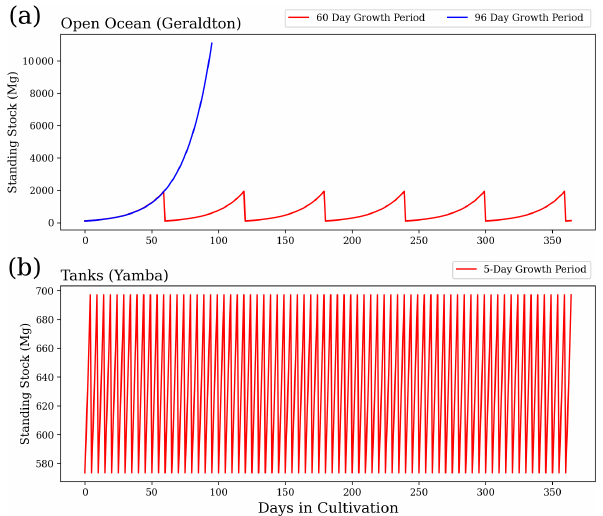
Figure 2. Standing stock biomass of Asparagopsis cultivation (a) in the open ocean for a 60d growth period and 96d growth period and (b) in terrestrial system culture for a 5d growth period. Each of the three scenarios will achieve an annual yield of ∼ 1 . 6 × 10 4